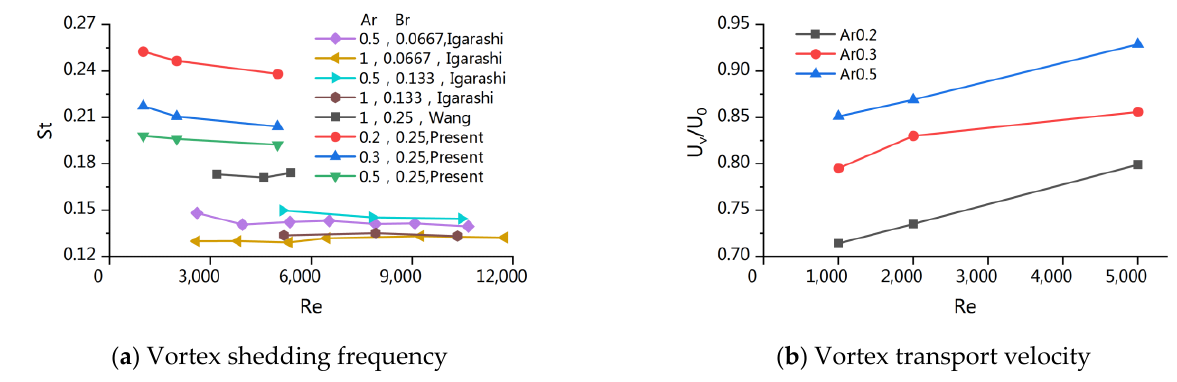
Figure 8. Characteristics of shedding vortexes: ( a ) the variation in the Strouhal number with the Ar and Br obtained by different researchers; ( b ) the non-dimensional vortex transport velocity obtained in this research.